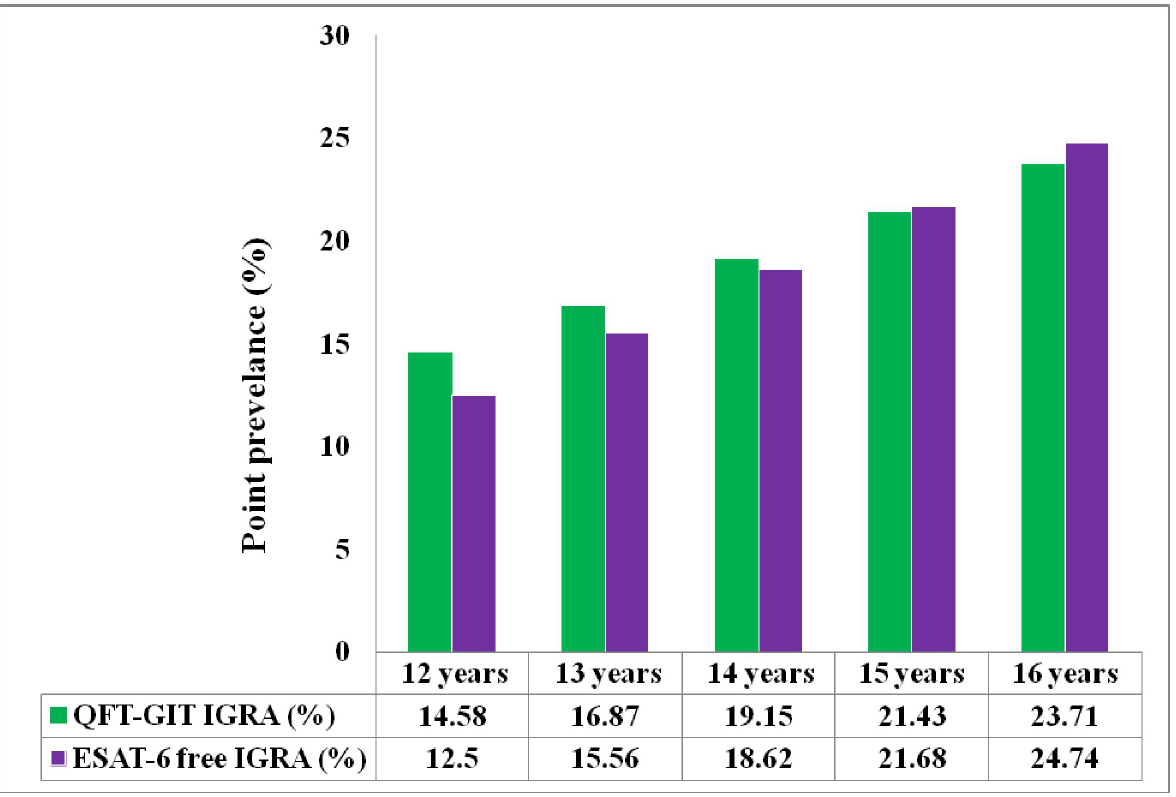
Fig 1. Bar chart summarizing estimates of latent tuberculosis infection (percentages) among adolescents by age for both the QFT-GIT IGRA and the novel ESAT-6 free IGRA tests. For 13—to 15-year-olds, the percentage data are estimates assuming a linear trend between prevalence determined in 12- and